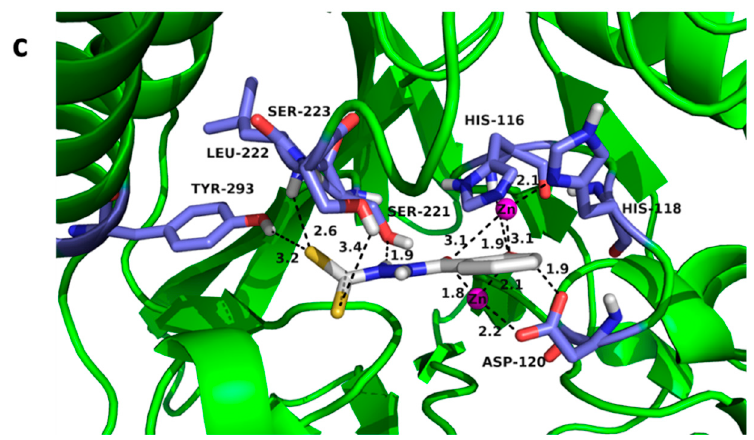
Figure 5. Lowest–energy conformations of DC1, docked into the active site of NDM-1 (PDB code 4EYL) ( a ), CphA (PDB code 2QDS) ( b ) and L1 (PDB code 2AIO) ( c ). Three enzymes were depicted as follows: backbone as cartoon in green; selected residues are shown as sticks, colored by element (H, white; C, skyblue; N, blue; O, red); Zn (II) ions were shown as magenta spheres; compound DC1 was also shown as sticks, with the same color code as amino acid residues, except C in is depicted as white and S as yellow. Characteristic short distances between inhibitors and the protein are indicated by dashed lines. These figures were generated with PyMOL.